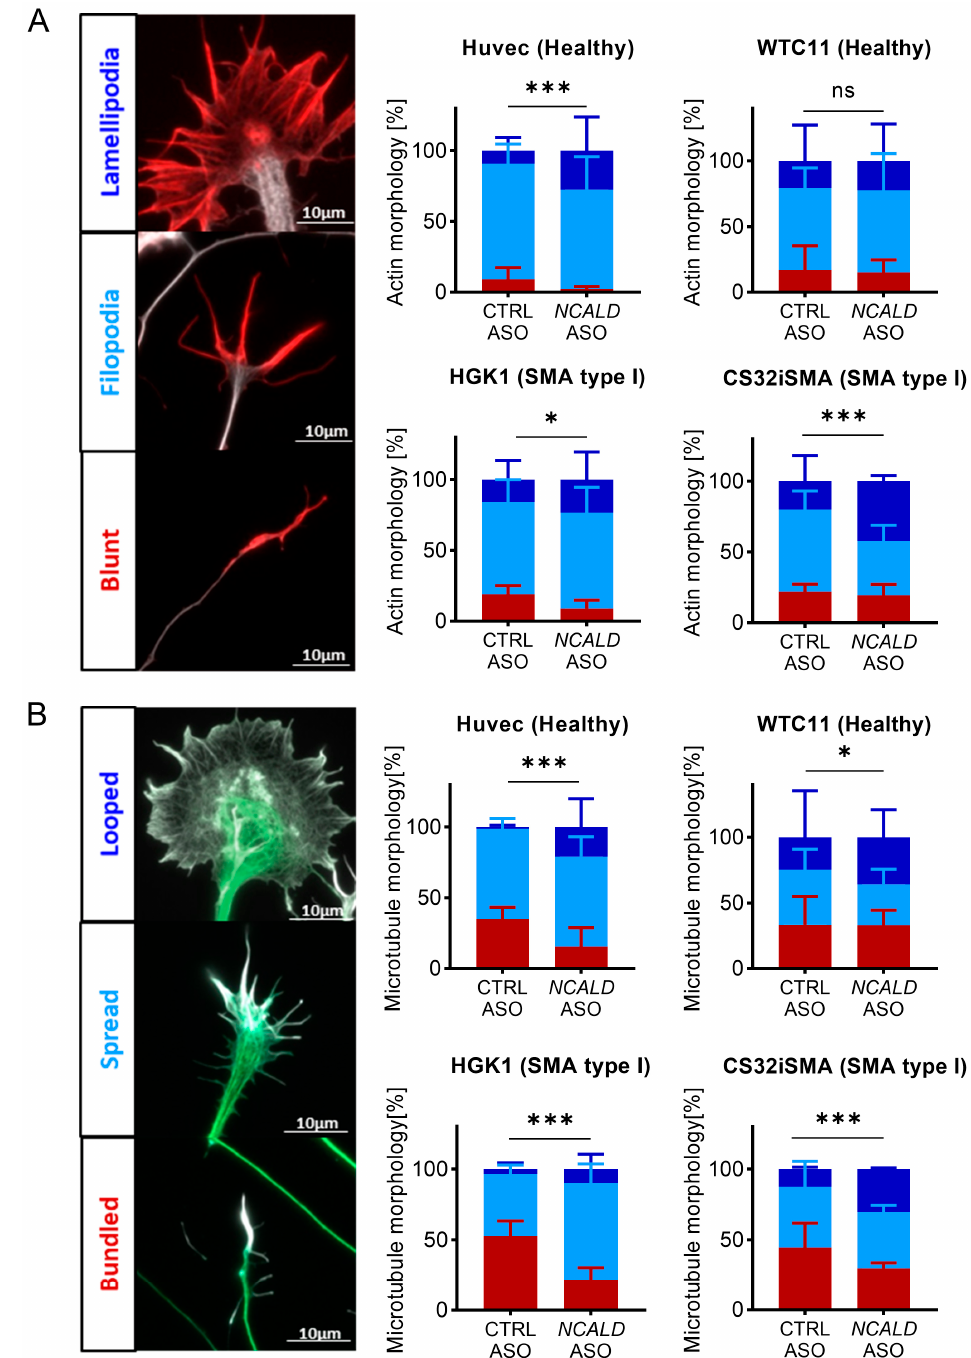
Figure 4. Analysis of cytoskeleton morphology upon NCALD -ASO69 treatment in hiPSC-derived MNs shows more mature growth cones. ( A ) For actin morphology analysis, actin was stained using phalloidin (red) and microtubules were stained using β -III-tubulin (TUJ1, white). Actin morphology was categorized as blunt ended, filopodia or lamellipodia based on the morphology of the filaments. Scale bar 10 µm. ( B ) Microtubules were stained using β -III-tubulin (TUJ1, green), and actin was counterstained using phalloidin (white). Microtubule morphology was categorized as bundled, spread or looped. Scale bar 10 µm. In total, three independent experiments from three independent differentiation were performed per cell line. HUVEC (N = 3; CTRL-ASO n = 141, NCALD -ASO69 n = 103), WTC11 (N = 3; CTRL-ASO n = 84, NCALD -ASO n = 85), HGK1 (N = 3; CTRL-ASO n = 138, NCALD -ASO69 n = 149), CS32isma (N = 3; CTRL-ASO n = 154, NCALD- ASO69 n = 146). Error bars show ± SD. Graphs represent percentages. * p ≤ 0.05, *** p ≤ 0.001 (Chi-square test). ns = not